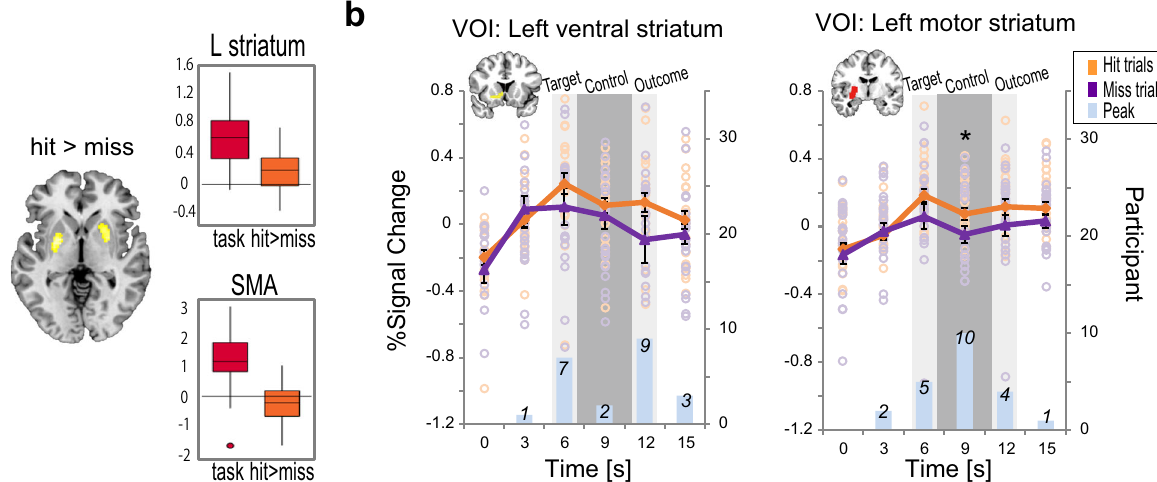
Fig. 3 Areas of greater activation during the hit trials than during the miss trials. a Only the bilateral dorsal striatum (yellow) showed greater BCI-related activity during the hit trials than during the miss trials ( P < 0.05 cluster-level FWE corrected). Supplementary motor areas (SMA) showed greater BCI- related activity during the miss trials than during the hit trials. The center lines of the boxplots indicate the medians, box limits indicate the lower and upper quartiles, the whiskers represent 1.5 times interquartile range, and circle indicates the outlier. b Signal change time courses for the left ventral and left motor striatum for the hit (orange) and the miss (purple). The number of participants who had the peak of the hit-minus-miss activity is shown in light bule bars. Both the ventral and motor striatum, de fi ned by diffusion MRI, showed BCI task-related activity. Only motor striatum exhibited greater activity for the hit trials than for the miss trials during the BCI control period (dark gray shaded areas, which lag 6 s behind the actual BCI control period to accommodate the hemodynamic delay). The peak of the hit-minus-miss activity is formed in the BCI control period in the motor striatum but not in the ventral striatum. Error bars indicate the standard error of the